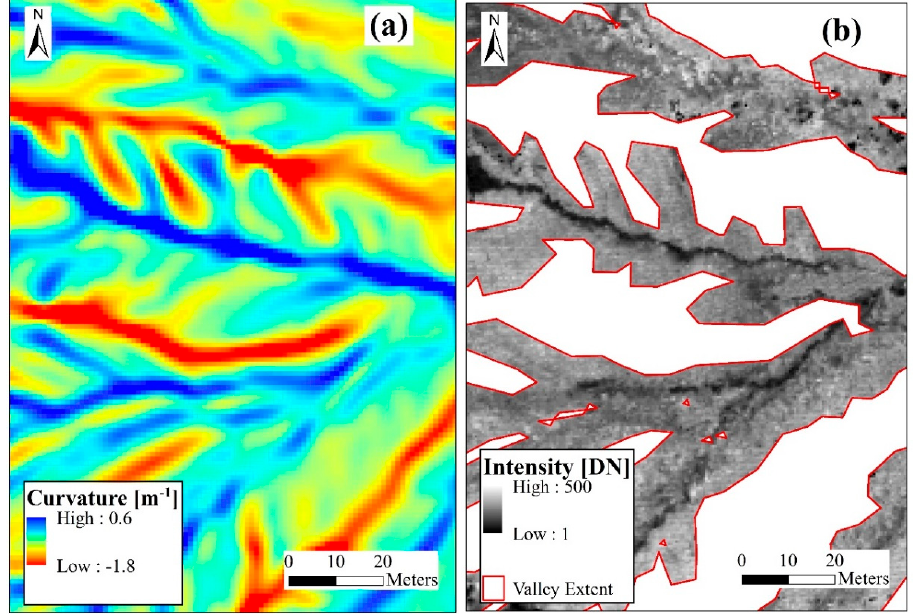
Figure 3. A contour curvature map and the identified valley extent determined by the curvature threshold in a sub-catchment of the Ward Creek watershed. ( a ) The contour curvature and the visible detection of the drainage path determined by blue color pixels. ( b ) The intensity returns within the valley extent determined by the curvature threshold in the Ward Creek watershed in the 2012 LiDAR survey [DN: digital number].